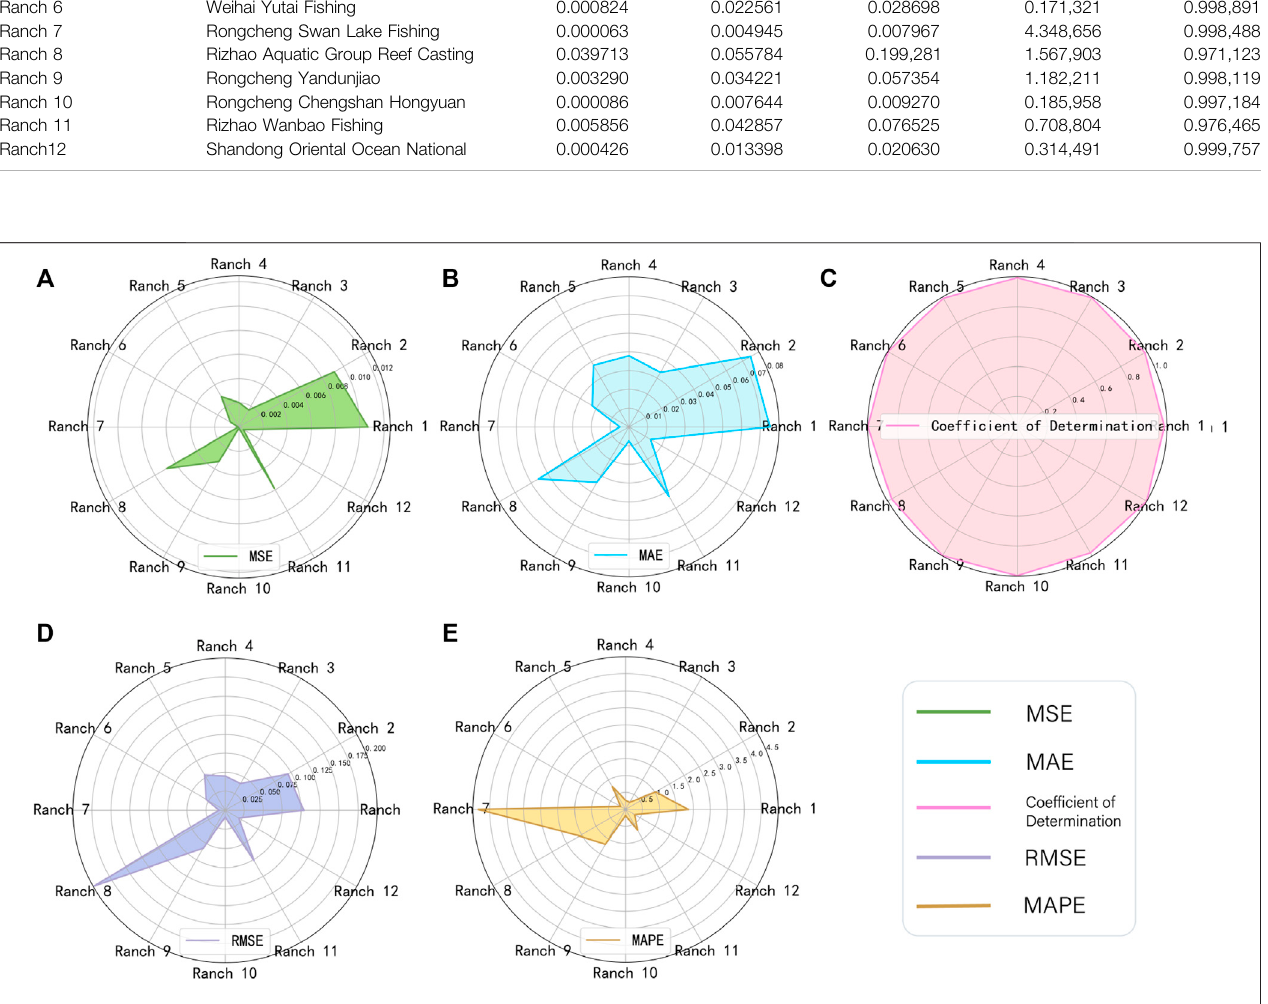
Frontiers in Environmental Science |